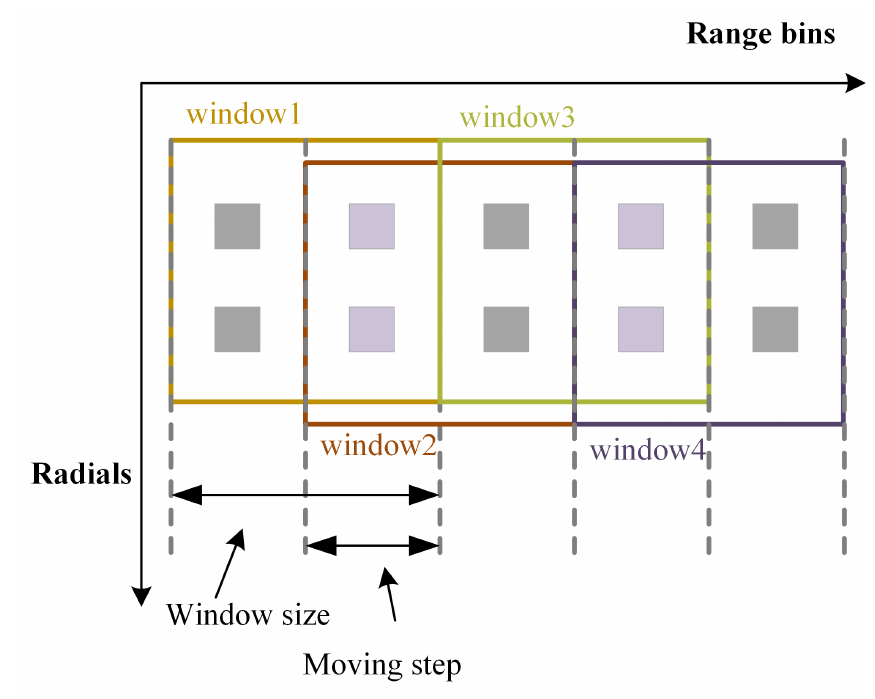
Figure 7. The sliding